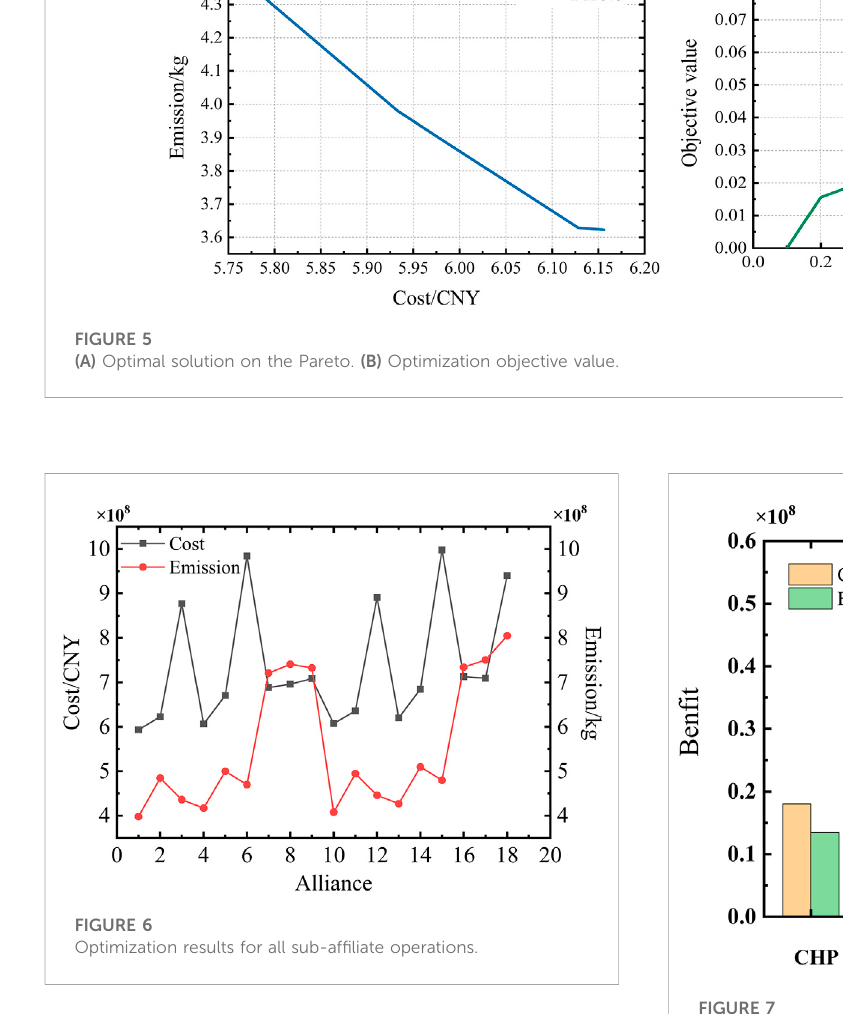
FIGURE 7 Bene fi t distribution